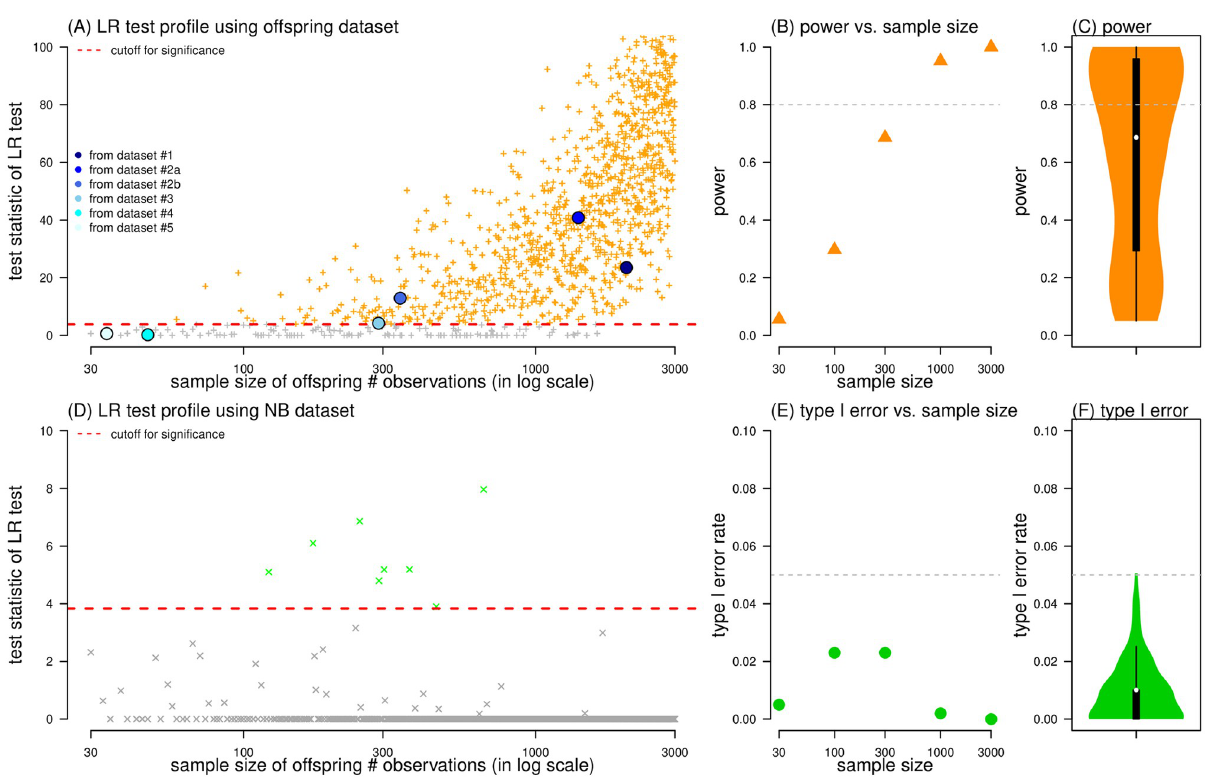
Fig 6. The power and type I error rate of the likelihood ratio (LR) test for Delaporte distribution against negative binomial (NB) distribution. Panels (A) and (D) show the test statistics (dots) from LR test, and the critical threshold (red horizontal dashed line) for p -value < 0.05. In panel (A), the ‘+’ dots are 10000 pseudo datasets generated by random sampling with replacement from the real-world datasets, and the circle dots represent datasets #1-#5. Panels (B) and (E) summarized the power and type I error rate of LR test for Delaporte distribution against NB distribution as a function of sample size. Panels (C) and (F) summarized the power and type I error rate of LR test with sample size reciprocal-distributed from 30 to 3000. In panel (D), the ‘ × ’ dots are generated by 10000 datasets generated by Monte Carlo sampling from NB distributions. In panels (B) and (C), the horizontal dashed line is the threshold of power at 0.80. In panels (E) and (F), the horizontal dashed line is the threshold of type I error rate at 0.05.